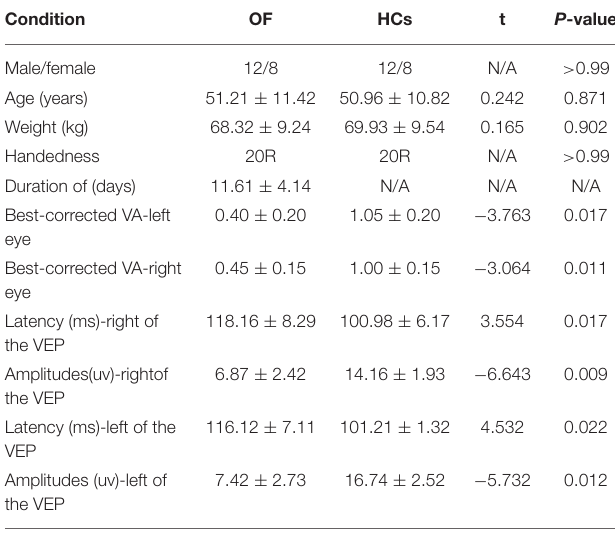
TABLE 1 | Basic information of the participants in the